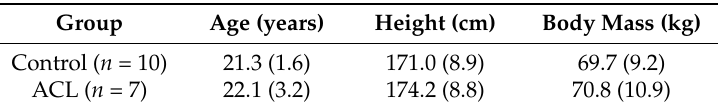
Table 1. Mean values for subject information of the control group and Anterior Cruciate Ligament (ACL) group. Mean (standard